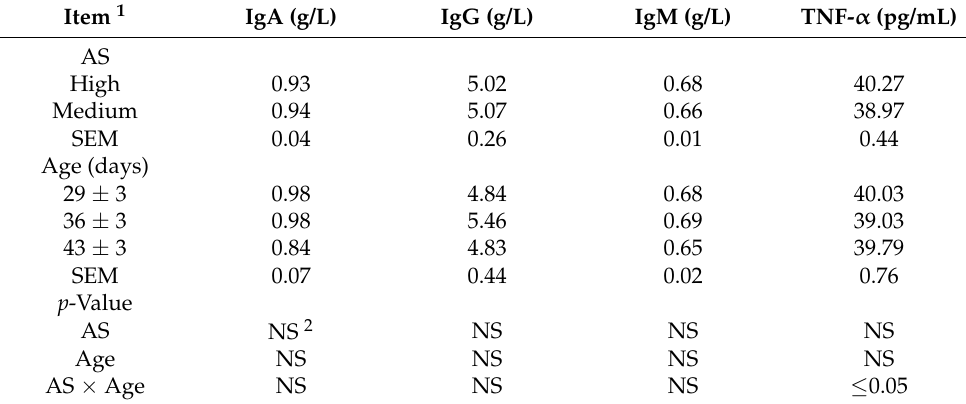
Figure 6. IgA ( A ), IgG ( B ), IgM ( C ), and TNF- α ( D ) concentrations among calves in D29-HA and D29-MA. Data represent mean ± SEM. Table 10. Immunity parameters of calves in D29-HA and